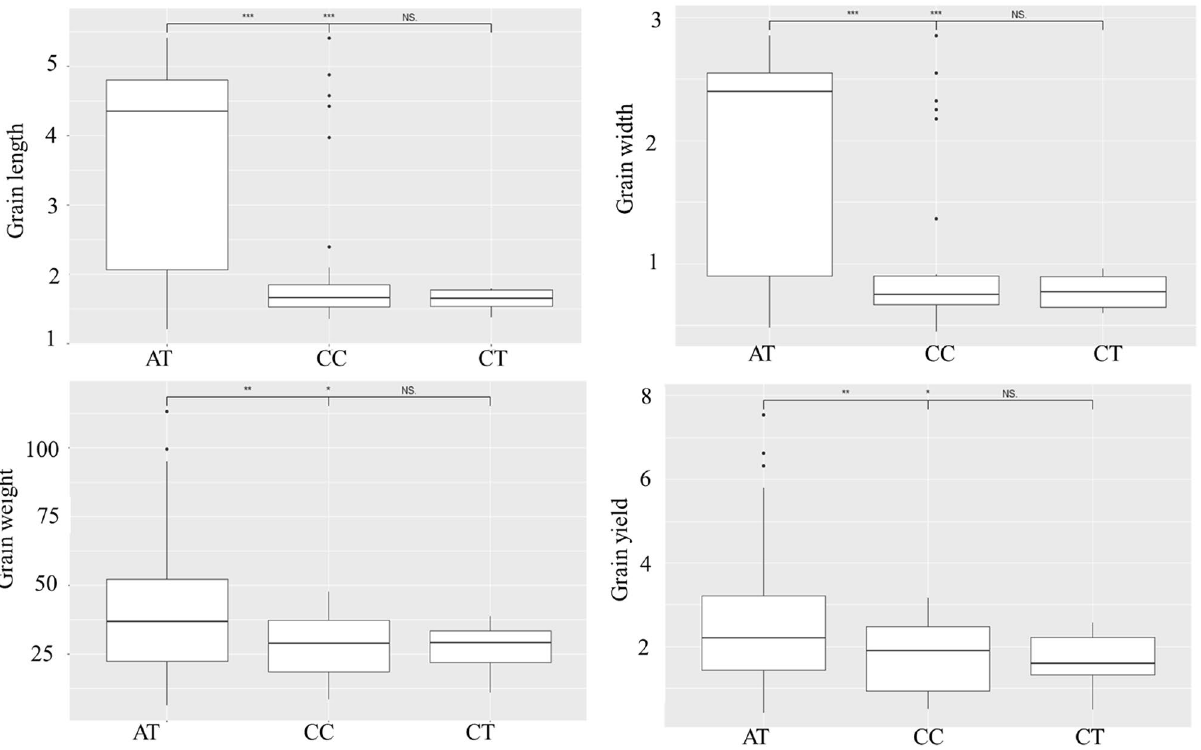
Figure 5. Impact of haplotypes on the grain traits and yield (using Wilcoxon test). Boxplots for the grain length (upper left), grain width (upper right), grain weight (bottom left) and grain yield (bottom right) are represented for each haplotype. ***, ** and *: significant at p < 0.001, p < 0.01, and p < 0.05, respectively. NS Not